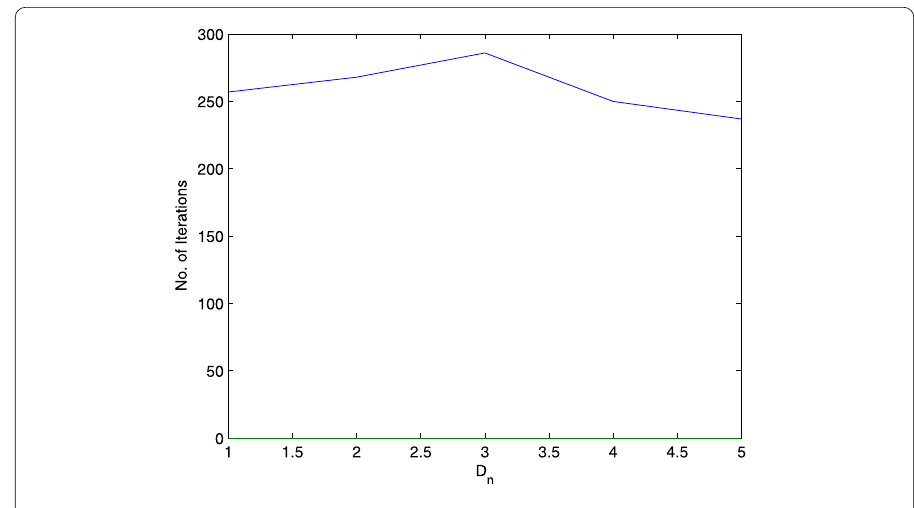
Figure 2 Comparison with tolerance of 10